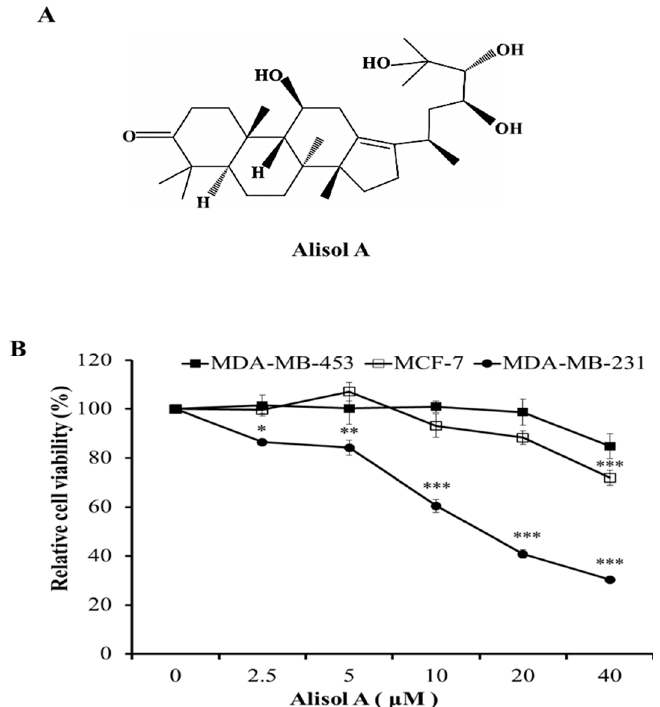
Figure 1. E ff ects of alisol A on cell viability in human breast cancer cells. ( A ) The chemical structure of alisol A. ( B ) E ff ects of alisol A on cell viability in MDA-MB-231, MDA-MB-453, and MCF-7 cells. Cells were treated with di ff erent concentrations of alisol A for 24 h. Then, cell viability was quantified by the MTT assay. Data represent the mean ± S.D of at least three independent experiments. * p < 0.05, ** p < 0.01, *** p < 0.001.